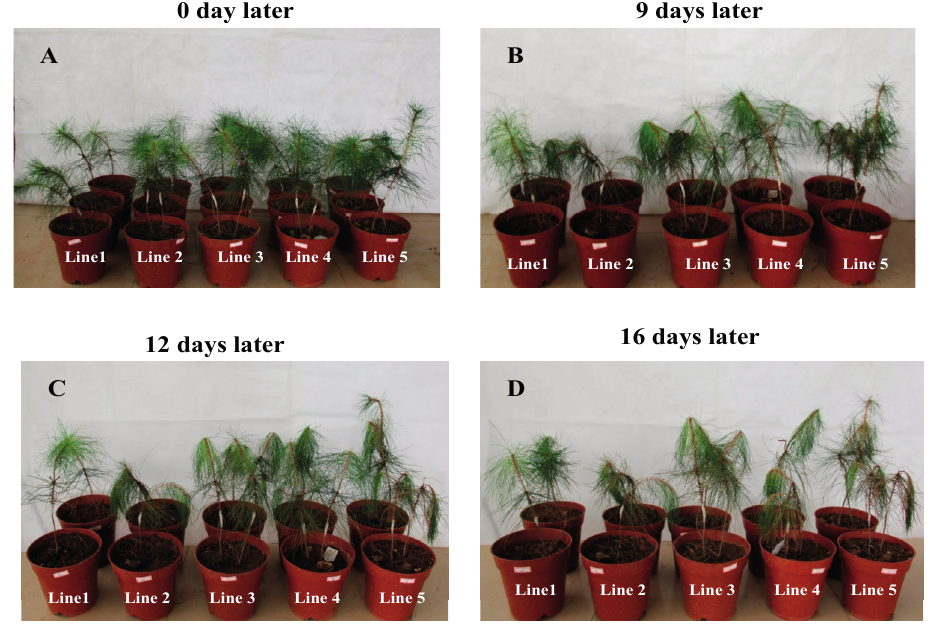
Figure 6. Symptoms in P. massoniana seedlings 0 ( A ), 9 ( B ), 12 ( C ) and 16 ( D ) days after inoculation with nematodes soaked in ds CYP33C9 (line 3), ds CYP33C4 (line 4) and ds CYP33D3 (line 5) solution and ddH 2 O (line 2). P. massoniana seedlings inoculated with ddH 2 O alone were considered as controls (line